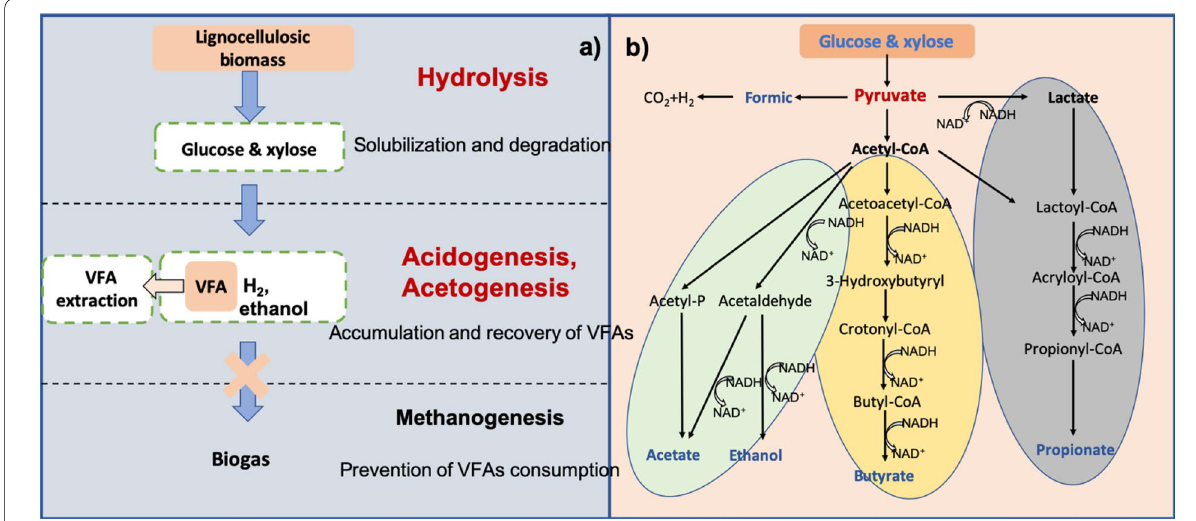
Fig. 2 a Schematic flow of formation of VFA during anaerobic digestion; b typical metabolic pathways of acidogenic fermentation (Adapted from Zhou et al. (2018) with permission/license granted by the